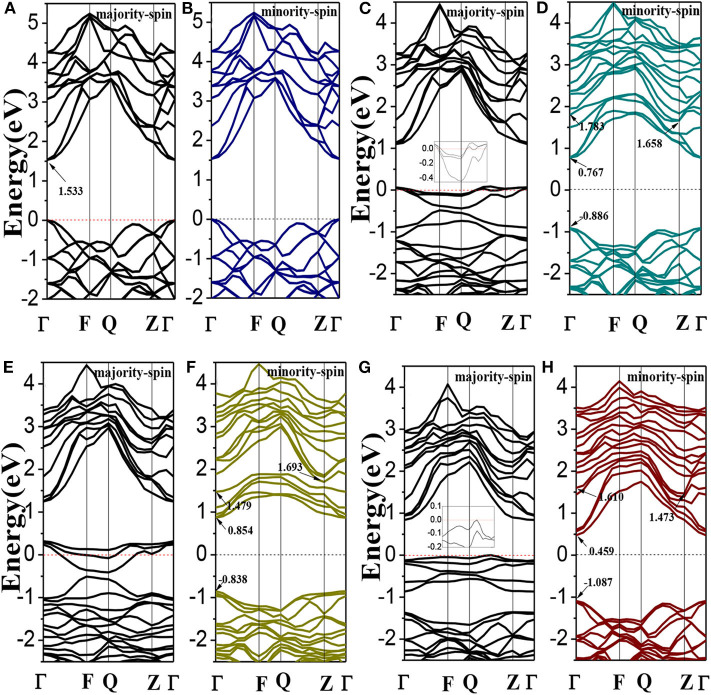
The band structures of Li1±y(Mg1−xCrx)P: (A,B) LiMgP, (C,D) Li(Mg0.875Cr0.125)P, (E,F) Li0.875(Mg0.875Cr0.125)P, and (G,H) Li1.125(Mg0.875Cr0.125)P. Inset: enlarged views of the vicinity of the Fermi energy level.